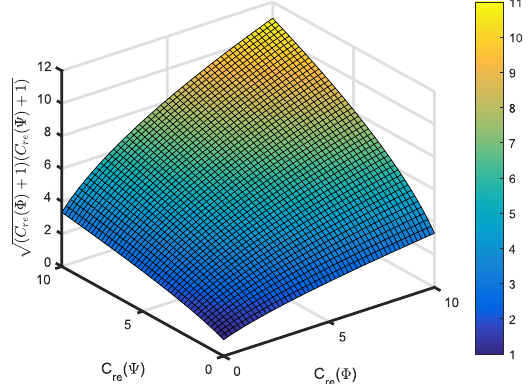
and n − 1. Here the domains of Φ C ( )